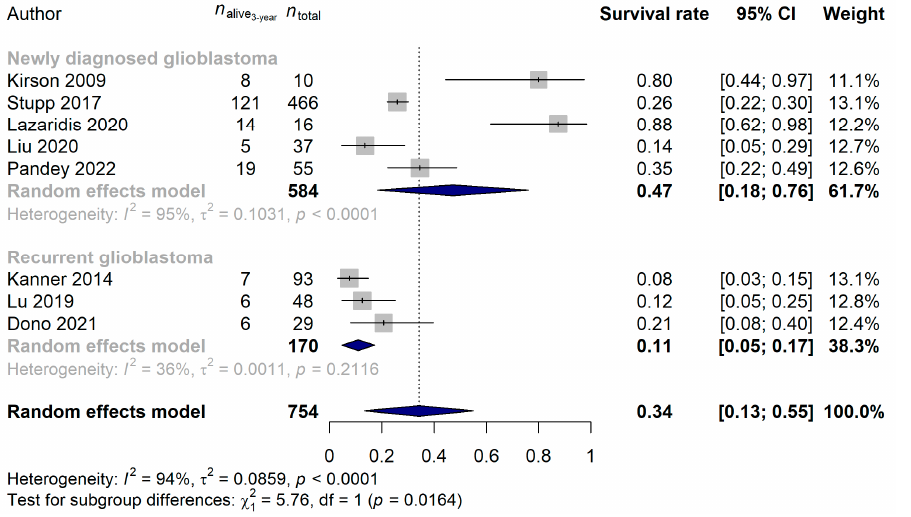
Figure 7. Significantly better 3-year survival rates were found when the Tumor Treating Fields treatment was introduced at an earlier stage of treatment ( p = 0.0164) [15,21,57,63,65,68–70]. Only a limited number of the available studies ( n = 5) investigated the effect of TTF over a control cohort. It was found that patients on the TTF-treatment arm had significantly better 1-year [risk ratio (RR): 0.6481, 95% CI: 0.4345–0.9668; p = 0.0335; Figure 8A] and 3-year (RR: 0.9215, 95% CI: 0.8819–0.9628; p = 0.0003; Figure 8C) survival rates. However, no difference could be observed in the 2-year survival rates of the patients treated with or without TTF (RR: 0.9032, 95% CI: 0.7713–1.0576; p = 0.2062; Figure 8B).